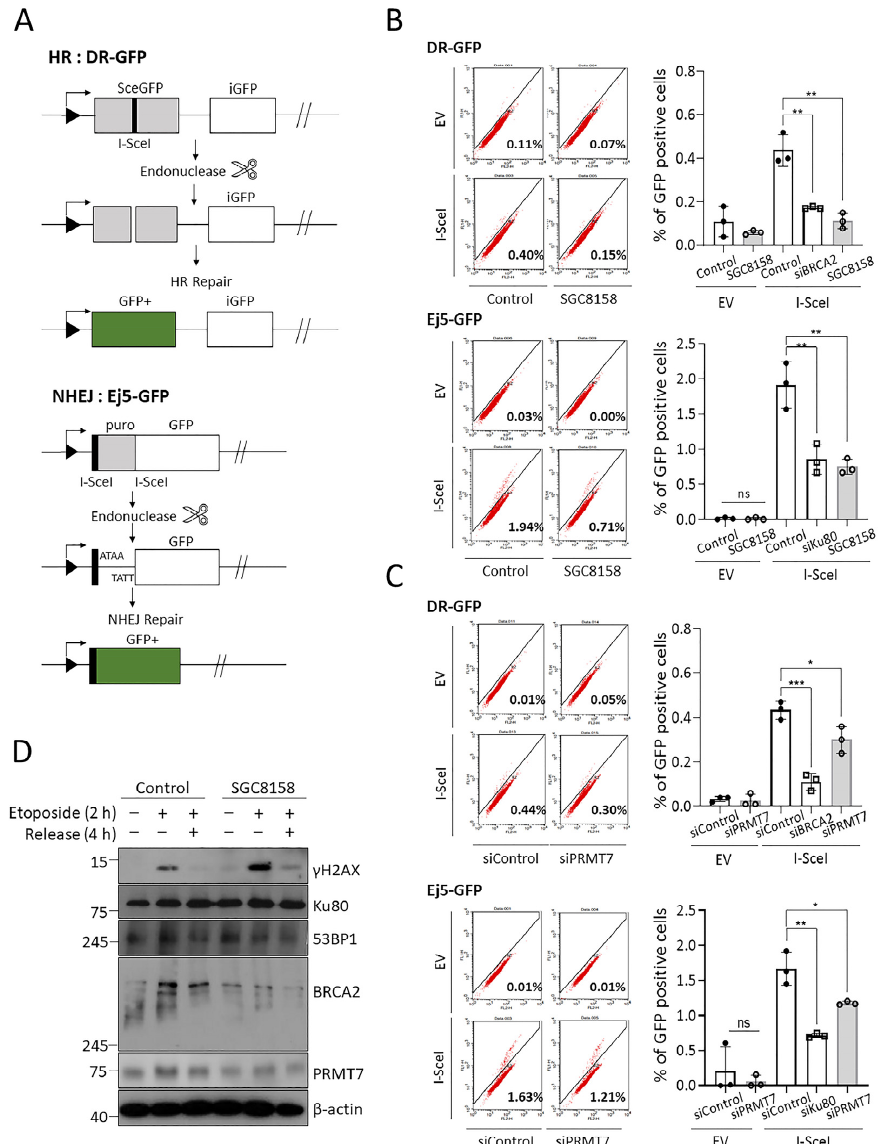
Figure 4. PRMT7 regulates DNA repair processes. Schematic of the DR-GFP and Ej5-GFP reporter assays. ( A ) DR-GFP reporter system was used to monitor HR process. Modified GFP gene ( SceGFP ) contains an I-SceI site in-frame. Expression of I-SceI causes DSBs at internal SceGFP sites and a non- functional GFP fragment gene ( iGFP ) is used to repair the DSB by HR, generating a functional GFP gene. In addition, the Ej5-GFP reporter system was used to monitor the total NHEJ process. The GFP gene is separated from its promoter by a puromycin resistance gene ( puro ) flanked by two I-SceI sites. Transient expression of I-SceI endonuclease causes the excision of the puro and induces the repair of the DSB by NHEJ, thus creating a functional GFP gene. ( B , C ) U2OS stable cell lines expressing DR-GFP or Ej5-GFP reporter constructs were co-treated (or transfected) with PRMT7 inhibitor (or siRNA) and I-SceI plasmid. After 3 days, the efficiency of HR or NHEJ was determined by counting the number of GFP-positive cells using flow cytometry. BRCA2 siRNA and Ku80 siRNA were used as positive controls to validate HR and NHEJ reporter systems, respectively. The percentage of GFP-positive cells from three independent experiments is indicated as the means ± SD. * p < 0.05, ** p < 0.01, and *** p < 0.001. ( D ) The expression levels of HR or NHEJ-related proteins (BRCA2, Ku80, and 53BP1) in the presence of SGC8158 were determined using western blotting under the same conditions. HR: homologous recombination; DSB: double-strand break; NHEJ: non-homologous end-joining; SD: standard